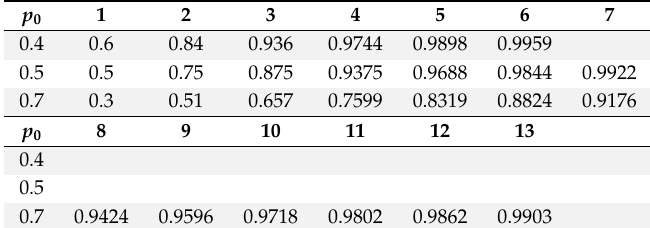
Table 10. Intermediate quantiles for different values of p 0